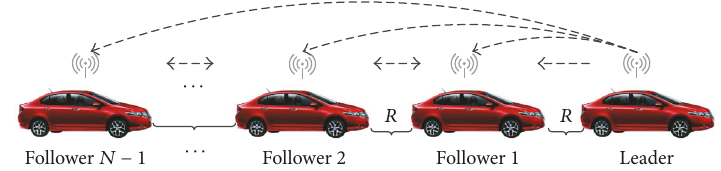
Figure 1: Topology structure of vehicle